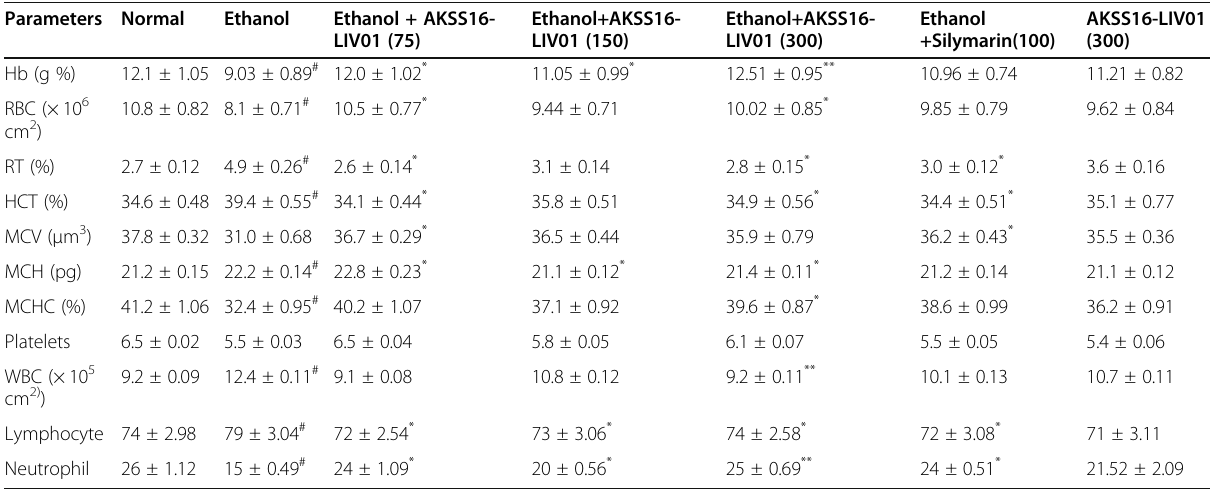
Table 7 Effect of AKSS16-LIV01 on haematological parameters in chronic ethanol-induced hepatic damage in mice Parameters